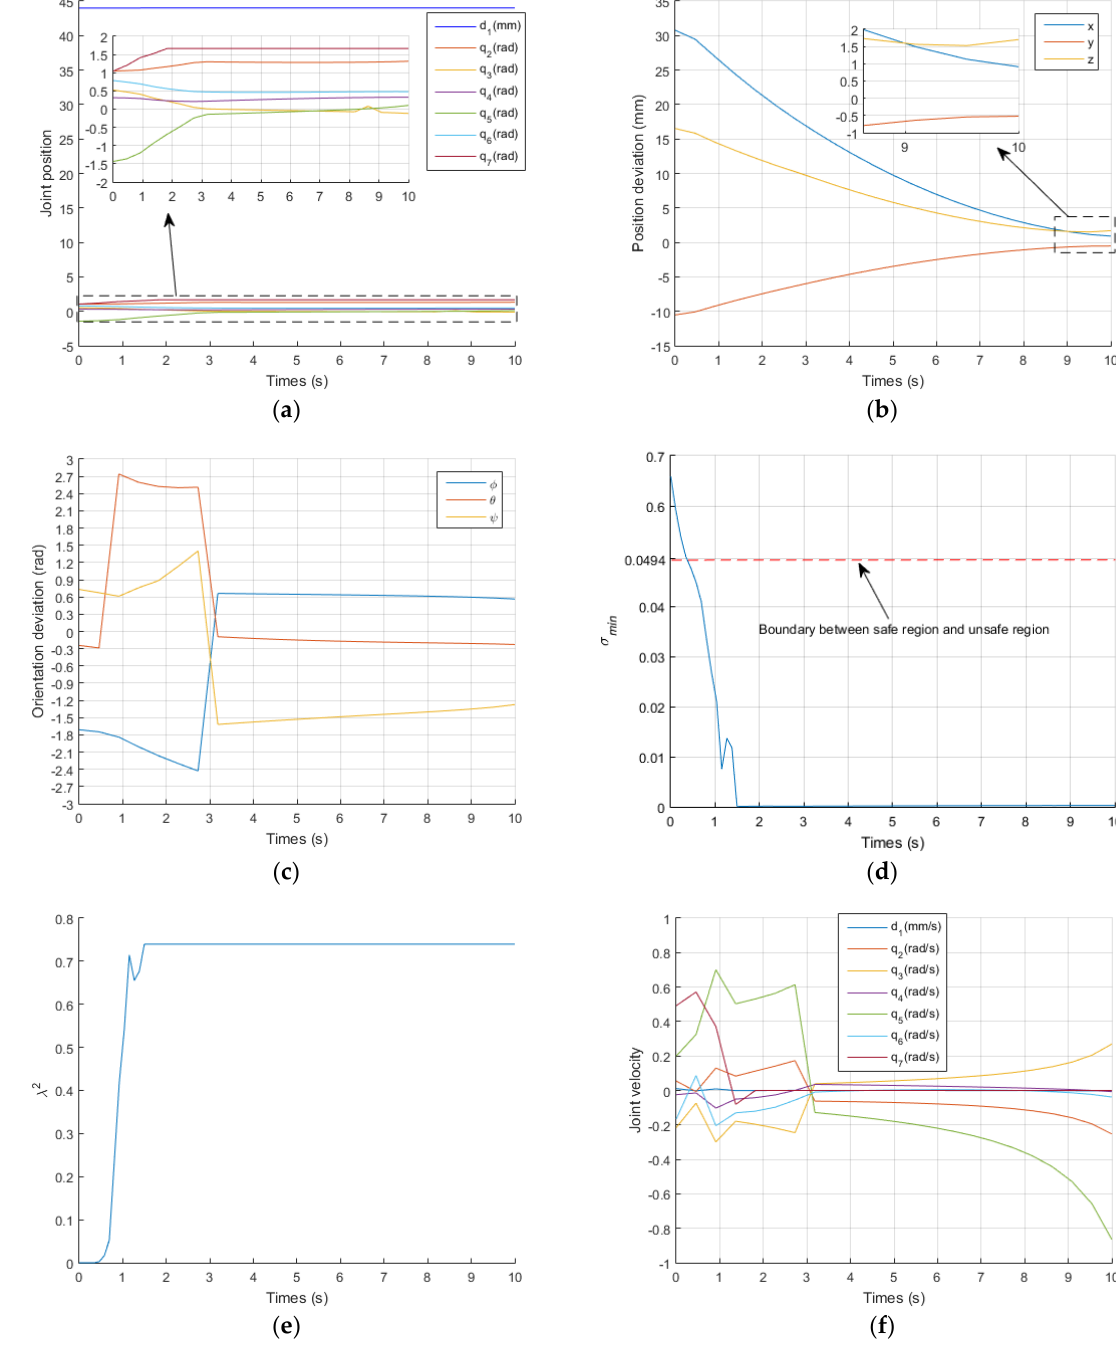
; ( e ) the change curve of  2 ; ( f ) the min